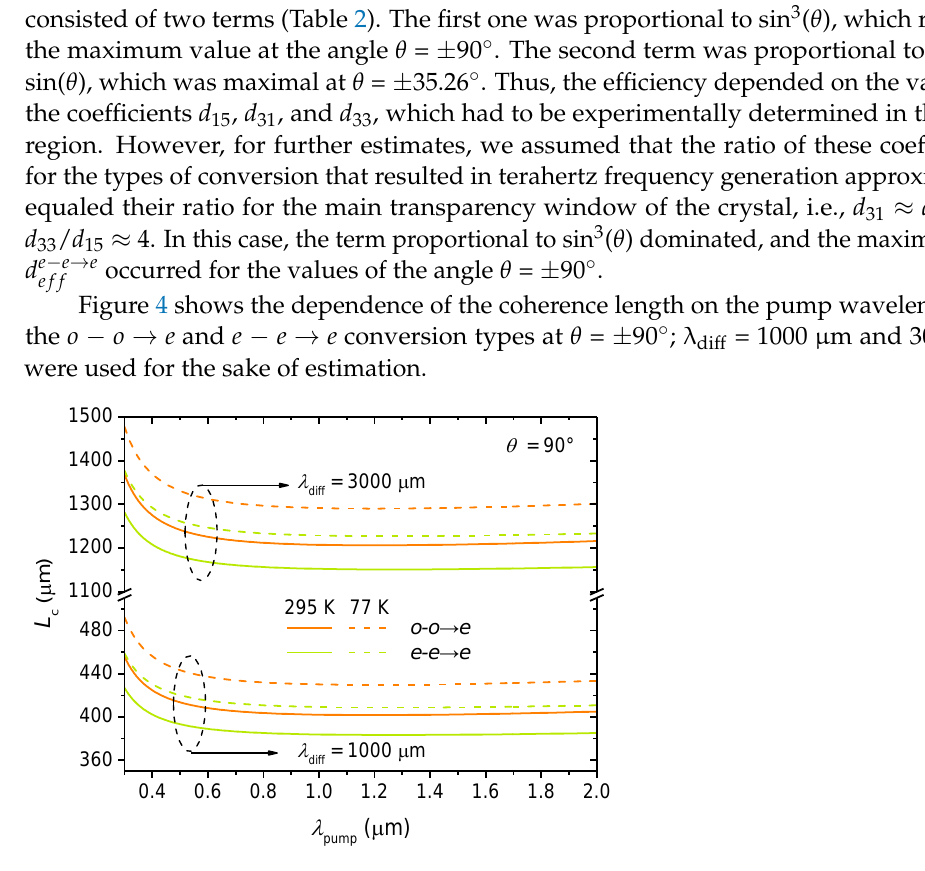
Figure 4. Dependence of the coherence length on the pump wavelength for the o − o → e and e − e → e conversion types that generate radiation at the wavelengths of 1000 and 3000 μm .